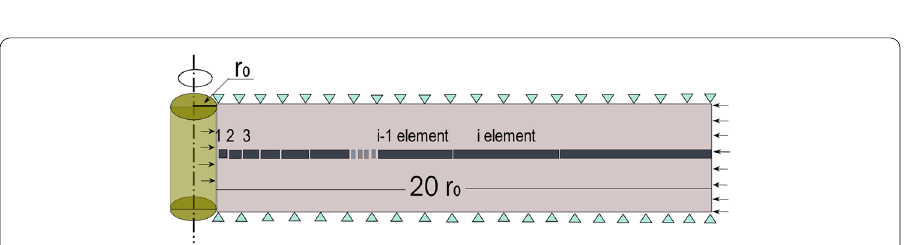
Fig. 4 Finite element mesh around pressuremeter